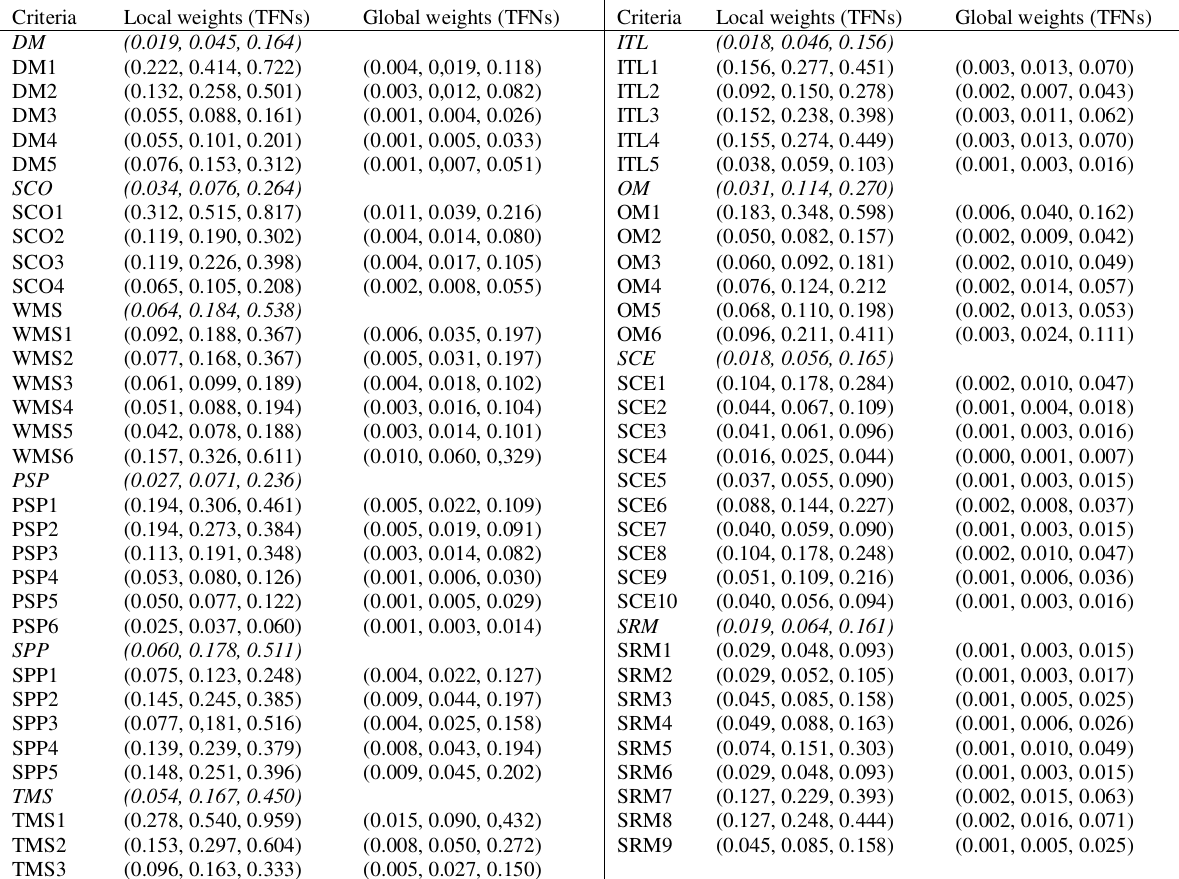
Table 4 Fuzzy Weights of the 60 evaluation criteria